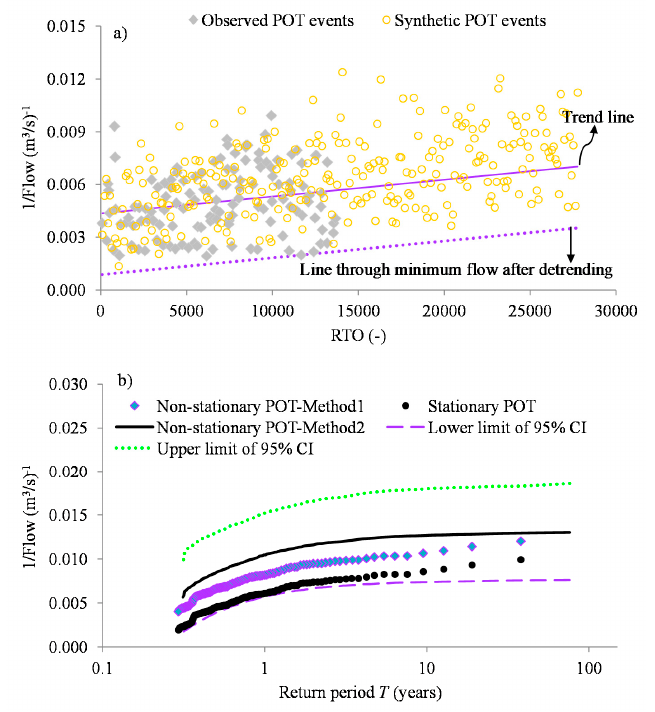
Figure 7. POT events of (1/ H ) low flows versus: ( a ) RTO; and ( b ) return period. In the legend of ( b ), “CI” stands for confidence interval on the T-year events from “Method 2”. For chart ( b ), the horizontal axis is based on logarithmic scale.